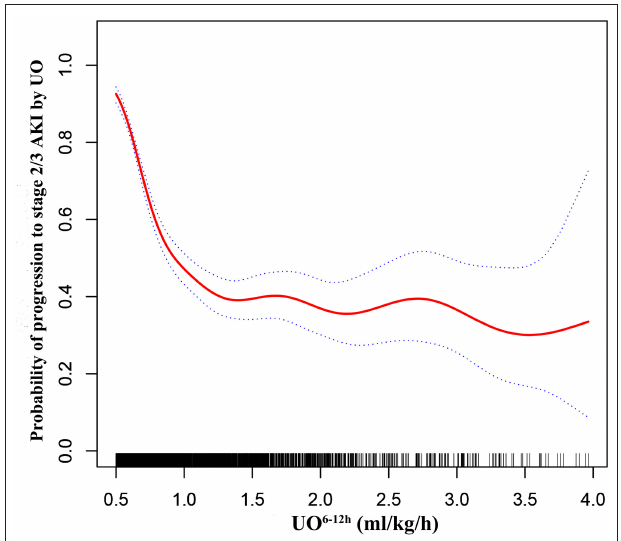
FIGURE 3 | Adjusted association between UO 6 − 12h and progression to stage 2/3 AKI by UO. A threshold, non-linear association between UO 6 − 12h and progression to stage 2/3 AKI by UO was found in a generalized additive model (GAM). Solid red line represents the smooth curve fit between variables. Blue bands represent the 95% confidence interval from the fit. All adjusted for age, gender, ethnicity, hypertension, metastatic cancer, liver failure, respiratory failure, heart failure, diabetes, Vasopressor 6 − 12h , Diuretics 0 − 24h , MAP 0 − 24h , SAPS II score, Scr at ICU admission, sepsis at ICU admission, fluid intake, and fluid balance. UO 6 − 12h , urine output within 6h after diagnosis of AKI by KDIGO UO criteria; MAP 0 − 24h , mean arterial pressure within 24h after diagnosis of AKI by KDIGO UO criteria; Vasopressor 6 − 12h , vasopressor use within 6h after diagnosis of AKI by KDIGO UO criteria; Scr, serum creatinine; KDIGO, Kidney Disease: Improving Global